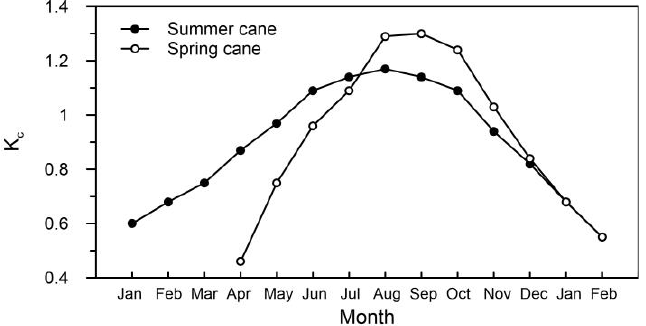
Figure 3. Annual variations in crop coefficients of summer cane and spring cane on Miyako Island (1980‒2003).